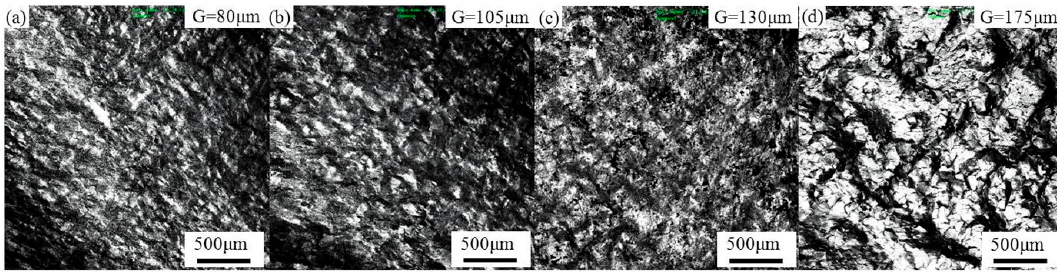
Figure 6. Surface morphology of bulged tubes with a mean grain size of ( a ) 80; ( b ) 105; ( c ) 130 and ( d ) 175 μ m.